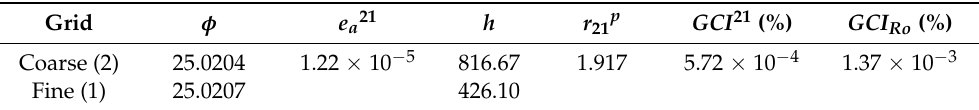
Table 3. Summary of results, low-pressure